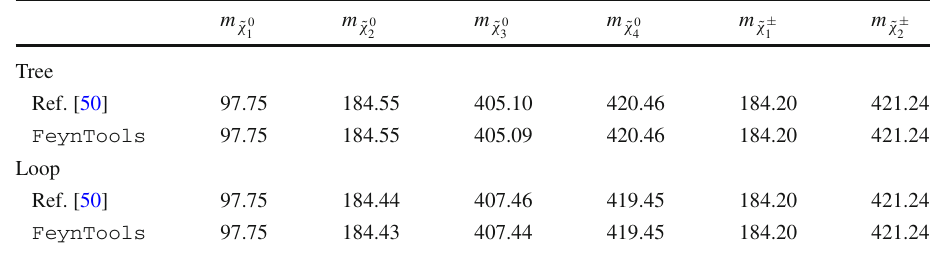
) (upper row) and σ( e + e − → ˜ χ 0 √ c (cid:4) s (in GeV) varied within the on-shell parameter set of SPS1 a (cid:4)